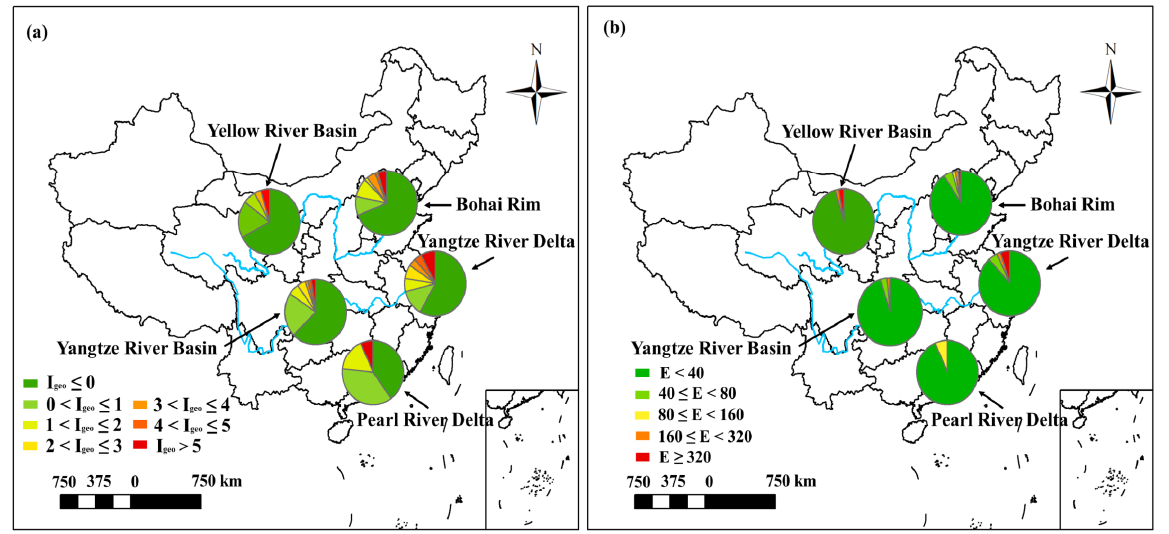
Figure 6. Class distribution of the ( a ) I geo and ( b ) E of the Yangtze River Delta, the Bohai Rim, the Pearl River Delta, the Yangtze River Basin, and the Yellow River Basin.